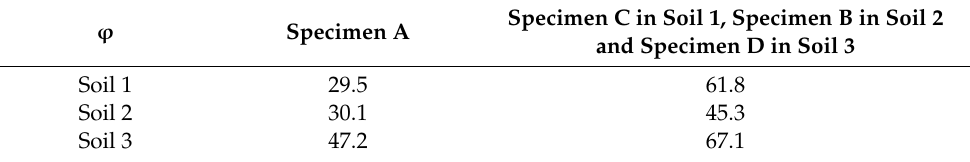
Figure 6. ( a ) Soil status after the experiments for the specimens with maximum and minimum force. ( b ) Stress results in soil simulations for the specimens with maximum and minimum force in soil 1, soil 2, and soil 3. ( c ) Force analysis during specimen penetration in soil 1, soil 2, and soil 3. ( d ) Vector-graphs of forces in soil 1, soil 2, and soil 3. Table 4. The direction of penetration force.